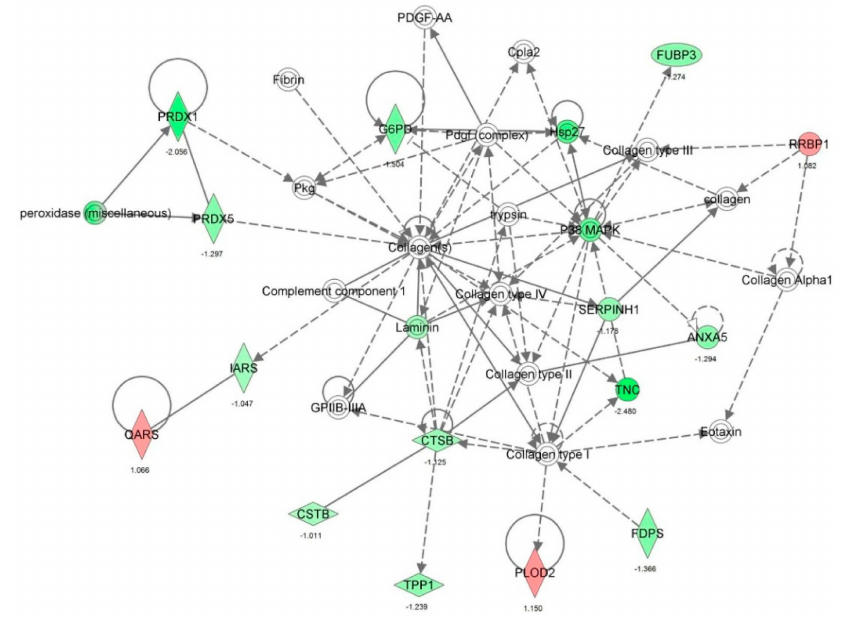
Figure 22. Vancomycin regulated cancer, endocrine system disorders, and organismal injury and abnormalities. Red indicates an up-regulation; green indicates a down-regulation. The intensity of green and redcolors indicates the degree of down- or up-regulation. Solid arrow indicates direct interaction and dashed arrow indicates indirect interaction.